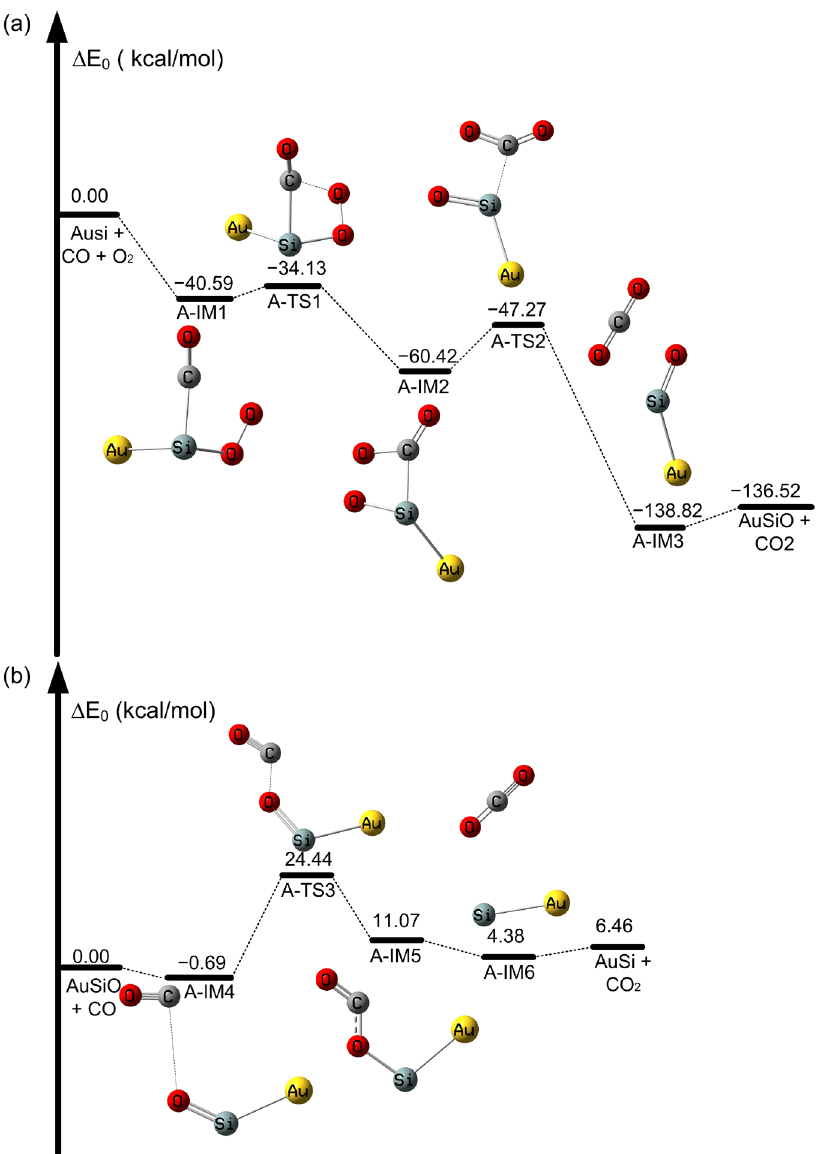
Figure 2. Potential energy profile of CO oxidation on SiAu atoms at the CAM-B3LYP/aug-cc-pVDZ- PP level. ( a ) Oxidation of CO on the SiAu cluster and ( b ) oxidation of CO on the OSiAu cluster (in kcal/mol).